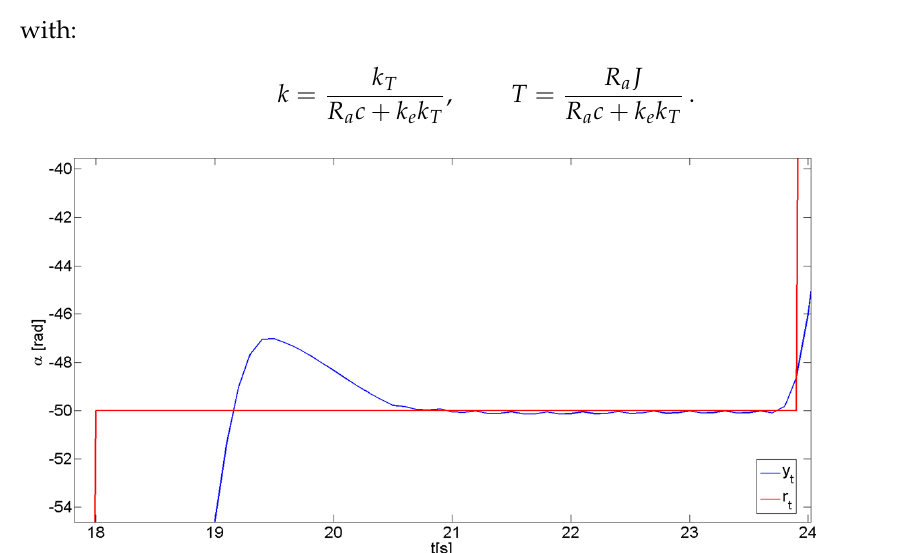
Figure 3. Position tracking with q u = 3000, N u = N y = 3, T S = 0.1